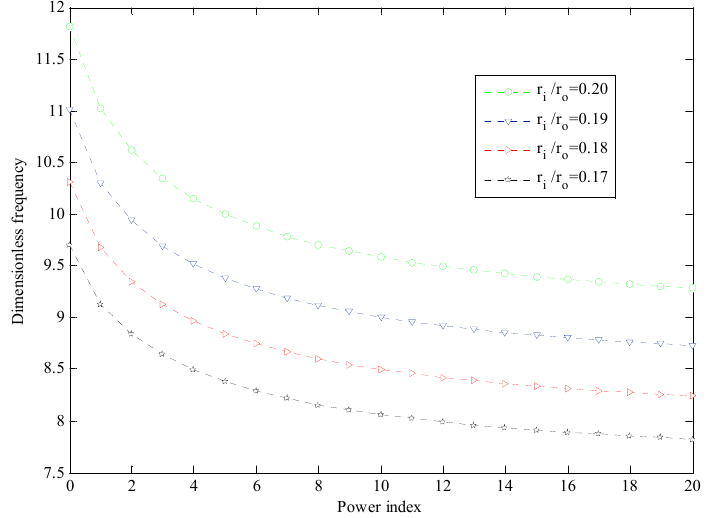
Figure 5. Dimensionless frequency versus thickness ratio for different variations in external mag- netic potential.